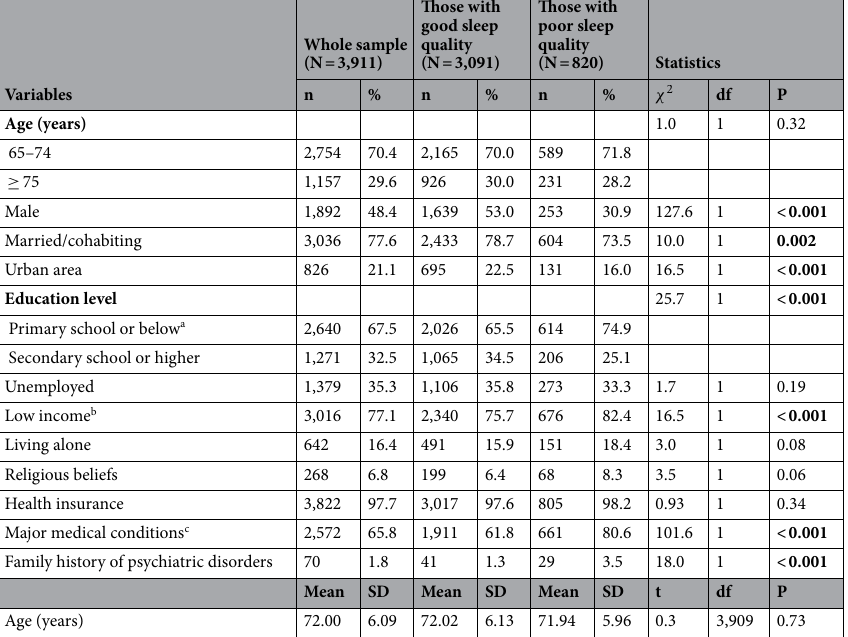
Table 4 presents the independent correlates of poor sleep quality. Female gender (P < 0.001, OR 2.4, 95% CI 2.00–2.82), rural areas (P = 0.002, OR 1.5, 95% CI 1.14–1.86), presence of major medical conditions (P < 0.001, OR 2.4, 95% CI 2.02–2.96) and family history of psychiatric disorders (P < 0.001, OR 2.7, 95% CI 1.60–4.39) were independently associated with poor sleep quality.